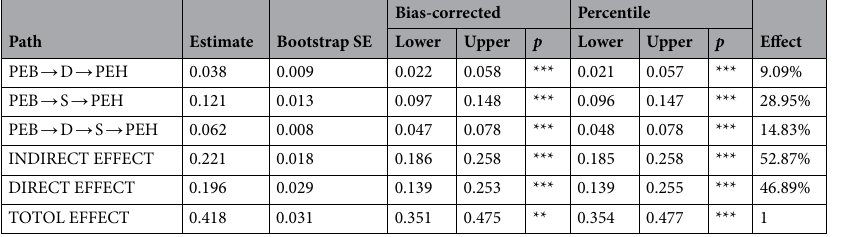
Table 5. Results of path